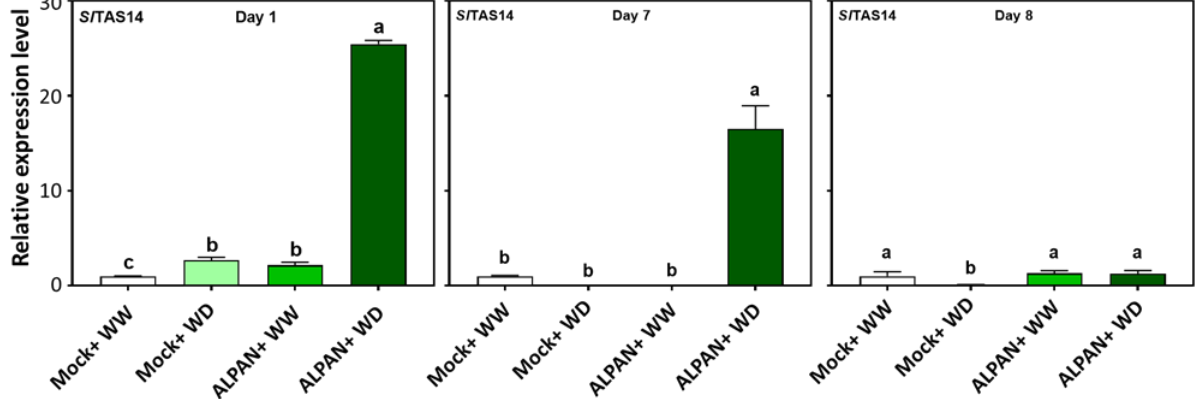
Figure 6. Expression levels of SlTAS14 after 1, 7, and 8 of the initiation of the water deficit stress. WW = well watered, WD = water deficit. Error bars above histogram columns represent the standard deviation of four independent biological replicates in each experimental group at each sampling timepoint. The statistical data were analyzed with the use of the one-way ANOVA and Tukey’s post hoc tests, and a statistically significant difference ( p -value < 0.05) is denoted by a different letter above a histogram column.